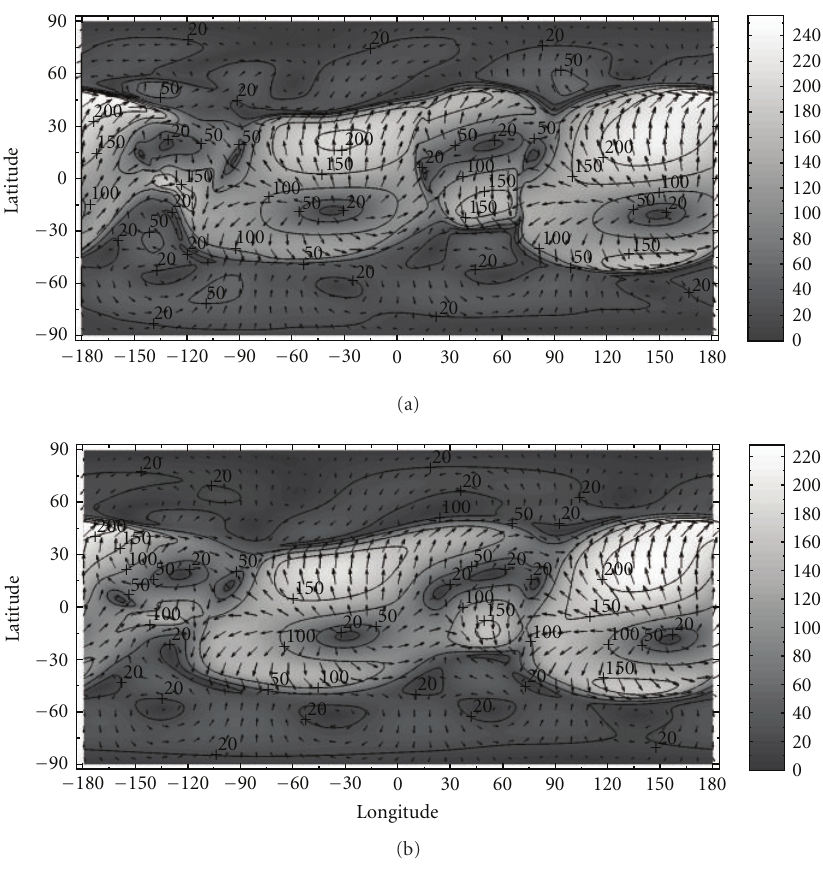
Figure 11: The same as in Figure 9 but at the altitude of 90